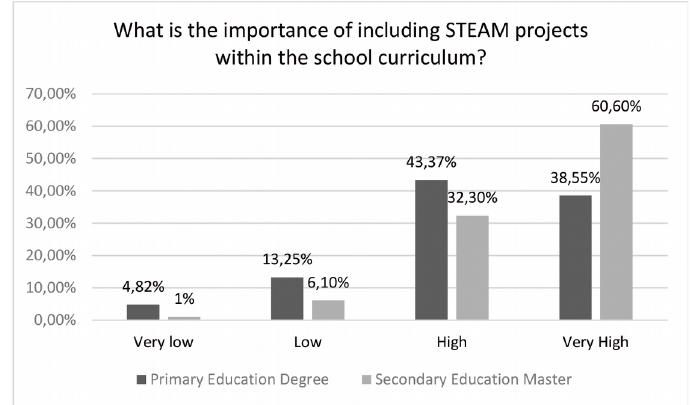
Figure 4. Level of importance for the inclusion of STEAM projects in the formal